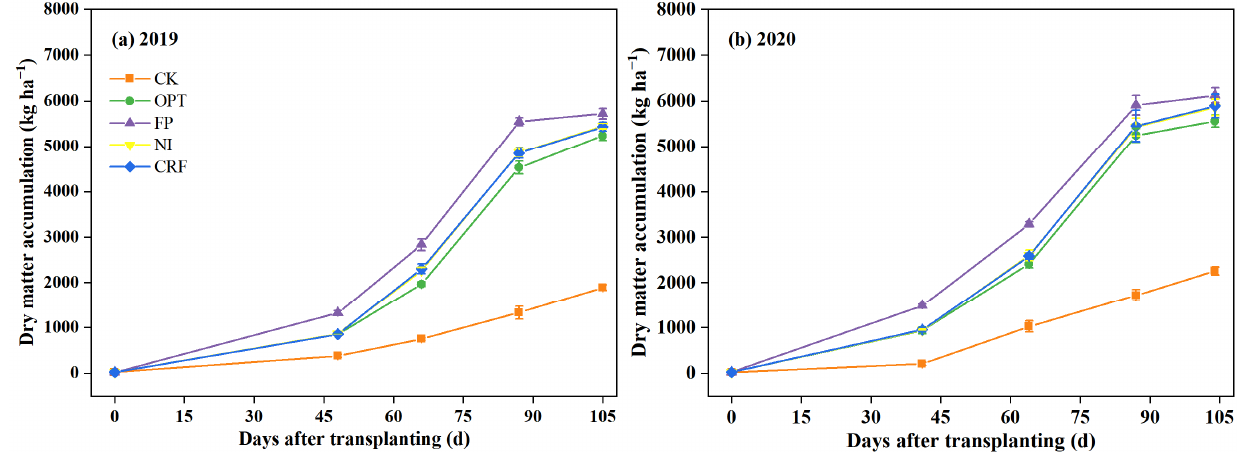
Figure 3. The dynamics of dry weight accumulation under different N management strategies in 2019 ( a ) and 2020 ( b ). The vertical bars represent the standard error ( n = 4).